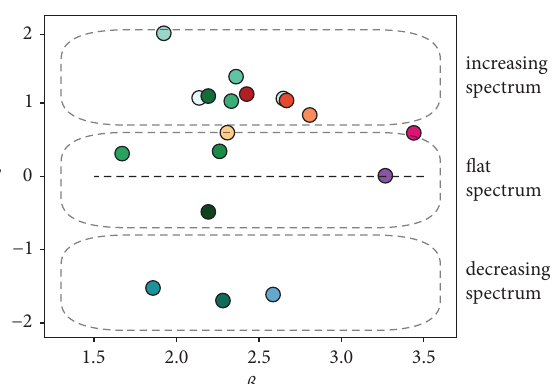
Figure 4: Spectral measurements on short time scales are either positively, negatively or not correlated. We plot estimates of the power law exponents β (long time scale) and c (short time